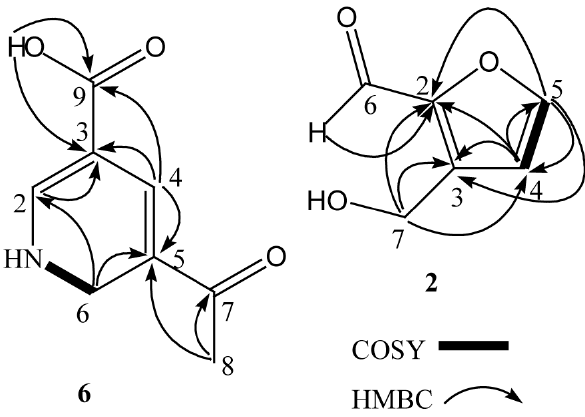
Figure 2. Key 1 H- 1 H COSY and HMBC correlations of 6 and 2 .